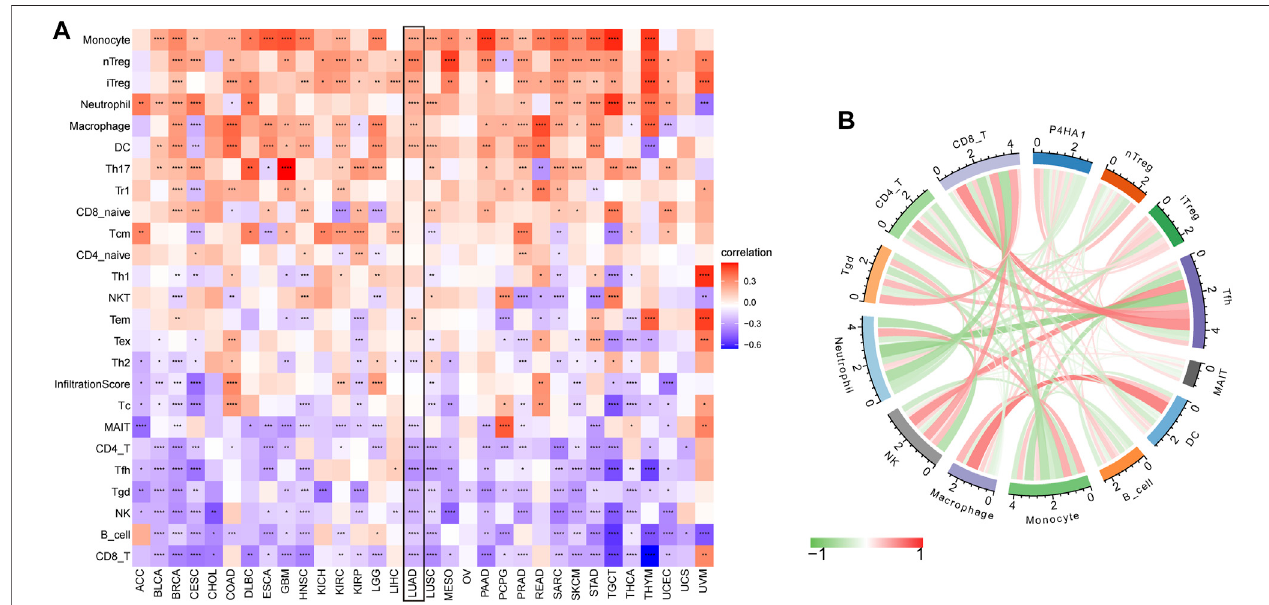
FIGURE 9 | Immune in fi ltration analysis based on data from ImmuCellAI database. (A) The relationship between P4HA1 expression and in fi ltration levels of 24 immune cells in pan-cancer. (B) The correlation between P4HA1 expression and immune cells in fi ltration in LUAD. Red lines represent positive correlation, and green lines represent negative correlation, and the darker the color, the stronger the correlation. * p < 0.05, ** p < 0.01, *** p < 0.001, **** p < 0.0001.